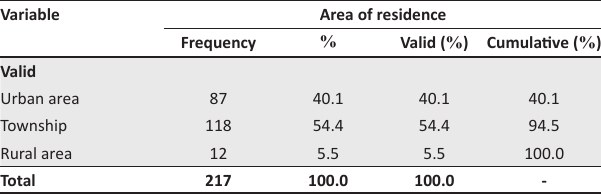
TABLE 2: Area of residence.